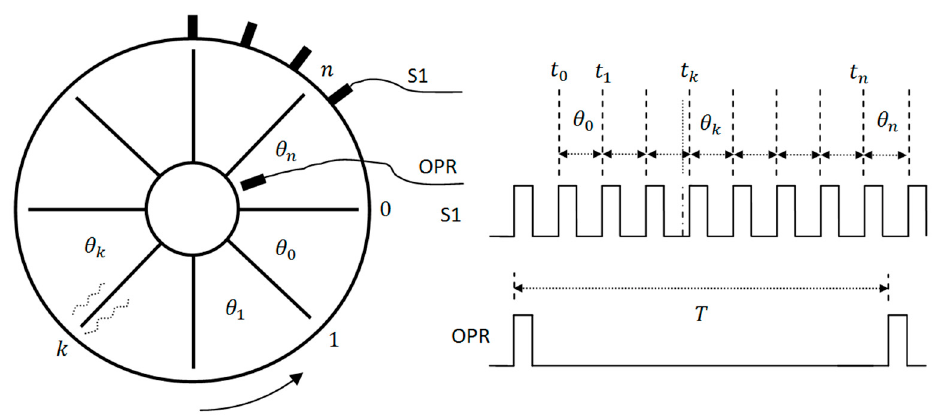
Figure 3. Measurement of the included angle distribution.